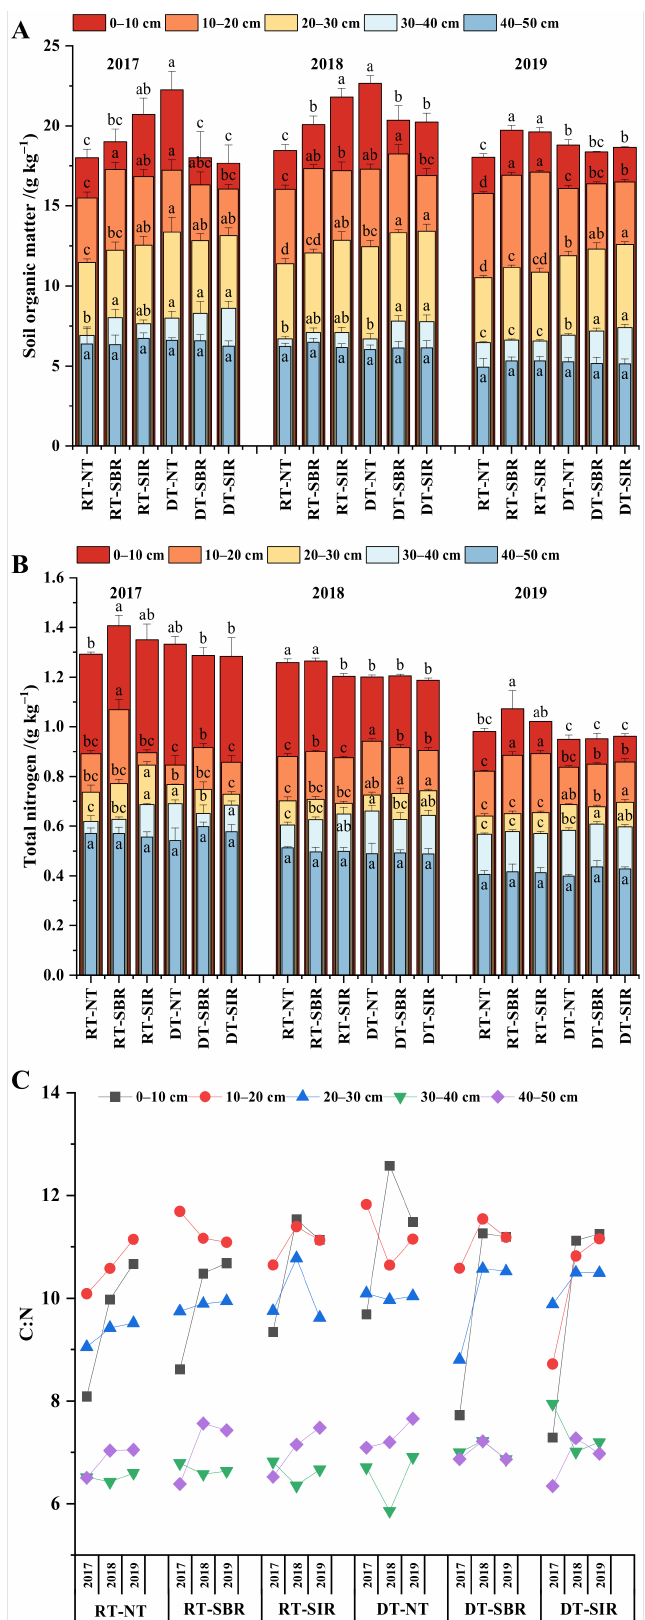
Figure 1. Soil organic matter ( A ), total nitrogen ( B ), C:N ( C ) under different treatments in different soil depths from 2017 to 2019 during the experiment. Bars represent standard error. Different lowercase letters above the bars represent significant differences among treatments ( p <